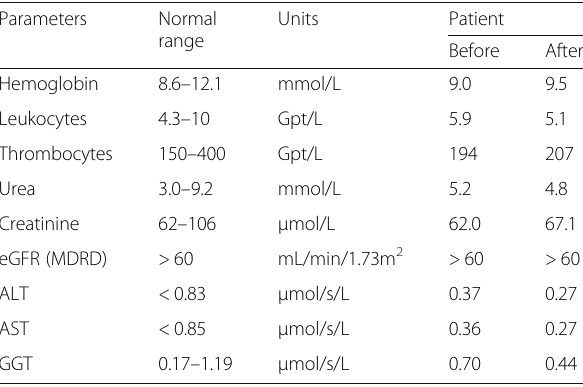
Table 3 Laboratory parameters of the patient before and after 152 Tb-PSMA-617